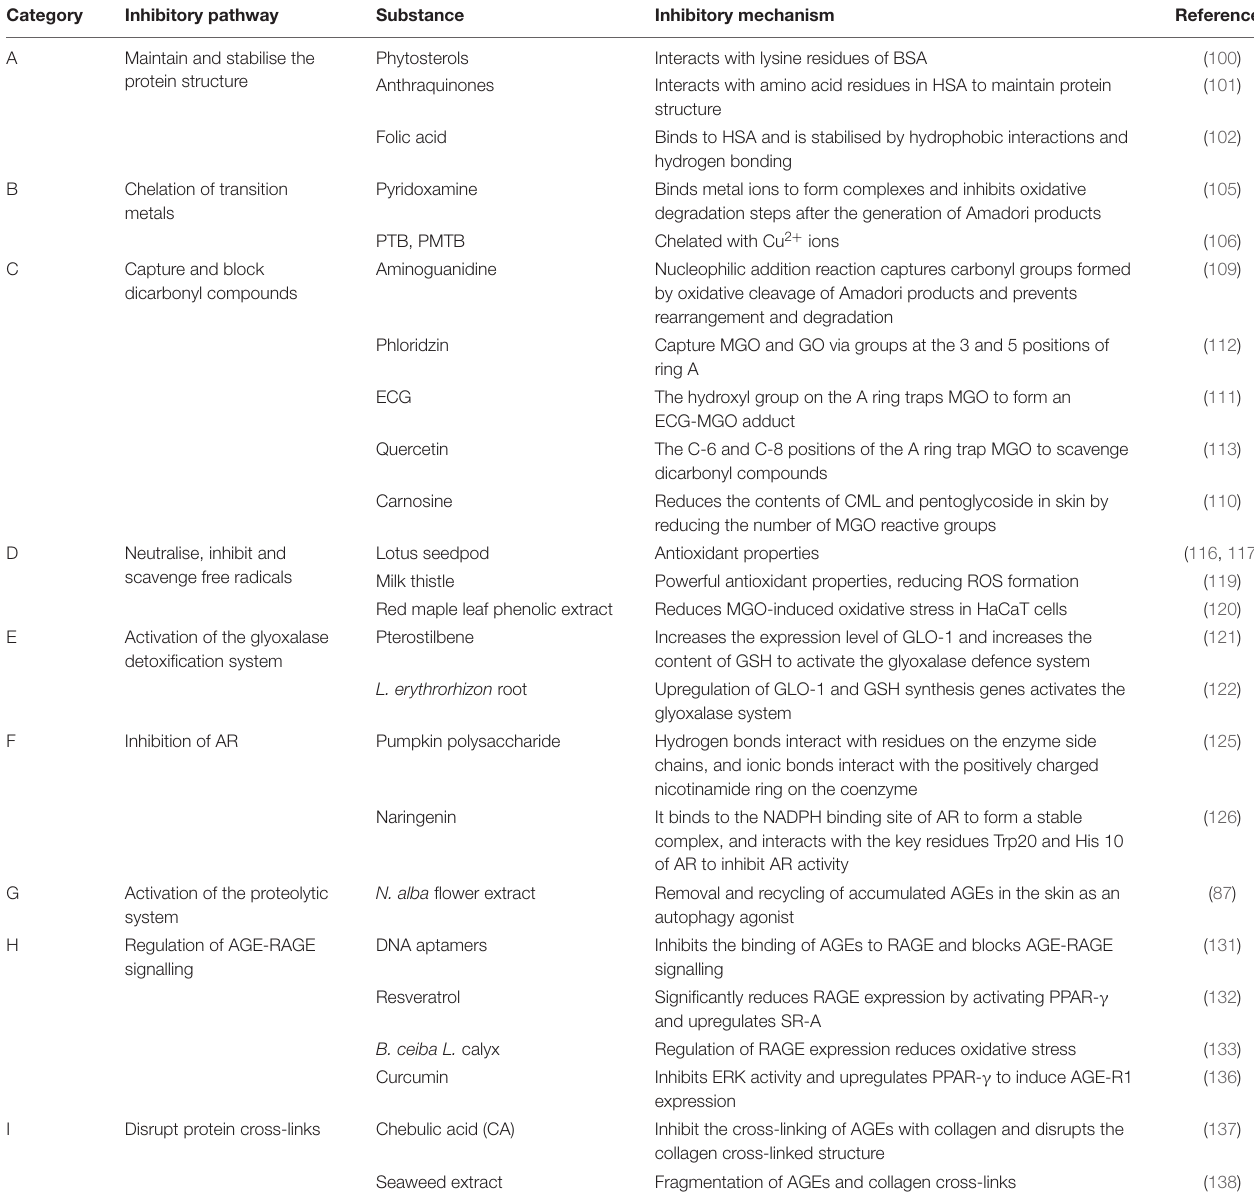
TABLE 3 | Compounds that inhibit the formation of advanced glycation end products (AGEs) and their mechanisms based on the categories of inhibitory